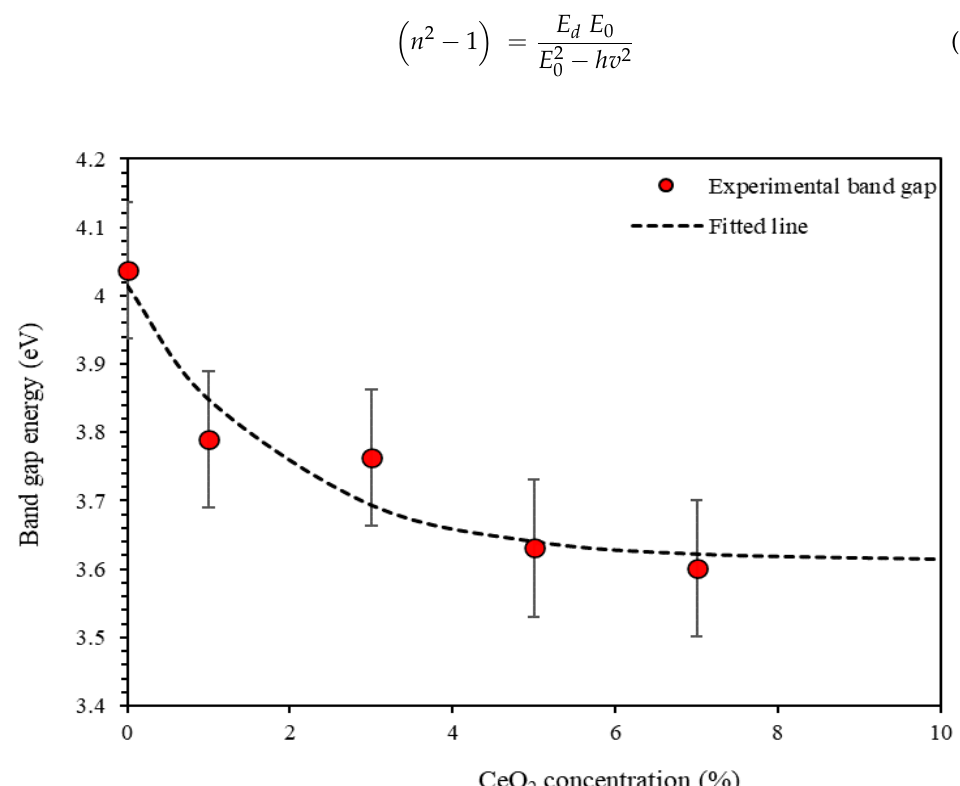
Figure 6. The energy band gap E g of PMMA-PS as a function of CeO 2 concentration. Wemple DiDomenico